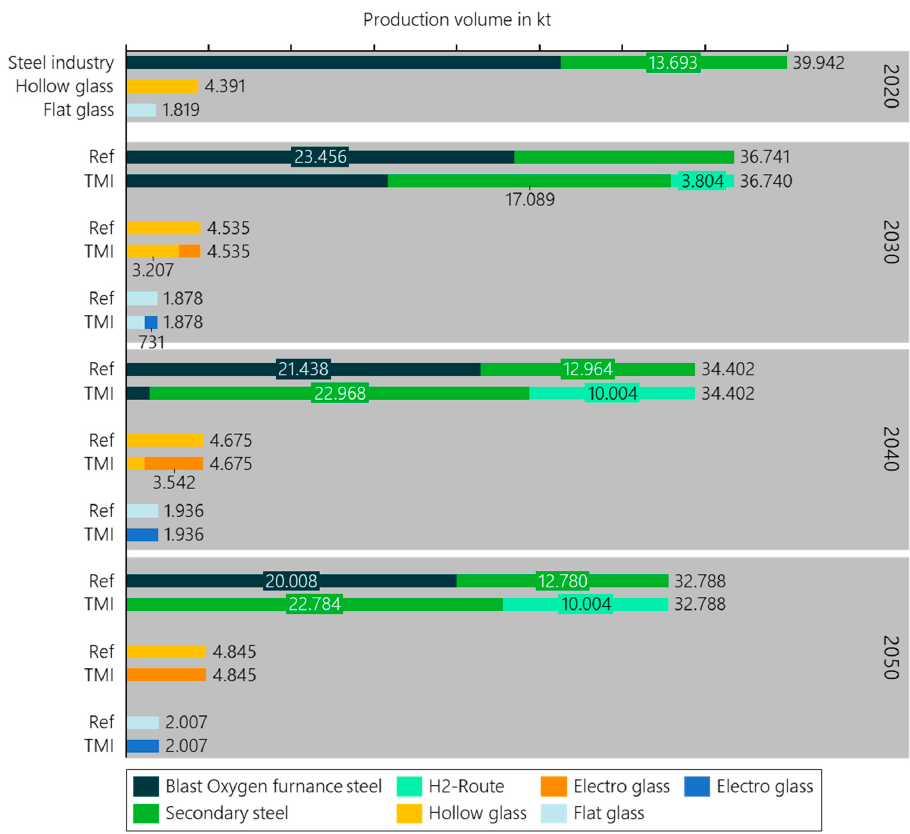
Figure A5. Production volume of processes according to measure category process route change in Reference and TMI scenarios between 2020 and 2050.